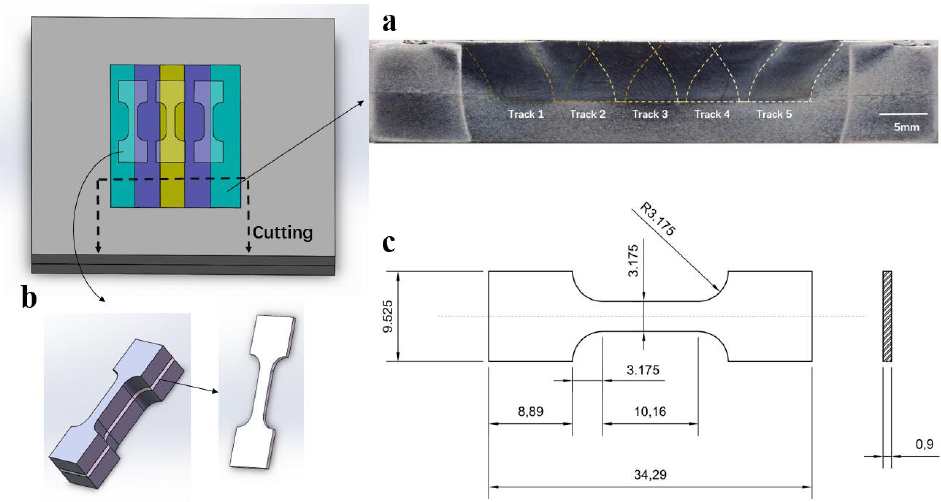
Figure 3. Sample preparation: ( a ) cross sections for microstructure observations; ( b ) manufacturing procedure of tensile specimens and ( c ) dimensions of tensile specimens.